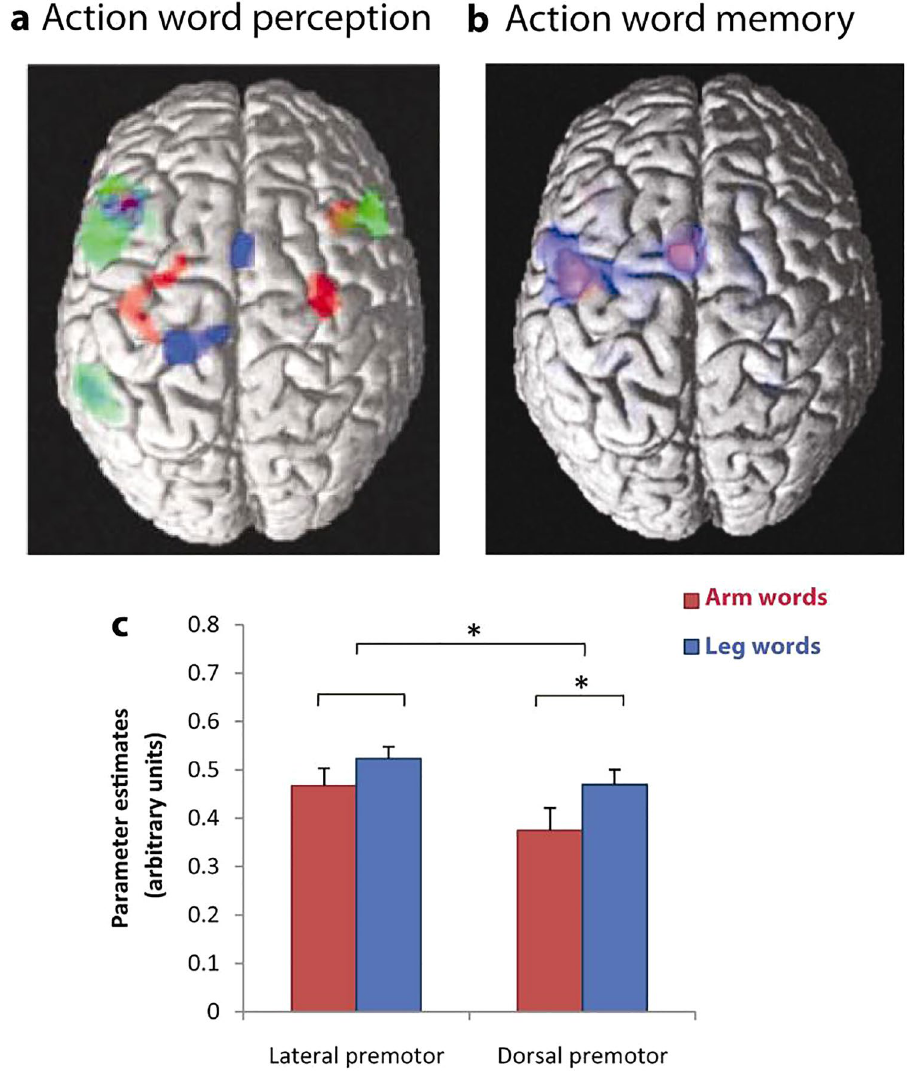
Figure 4. ( a , b ) Comparison between dorsal views of word category effects seen in the present working memory study and in an earlier study of word reading using a similar set of arm- and leg-related words 70 . The previous study’s results are displayed on the left, with activity to face-related words in green, that to arm-related words in red, and that to leg words in blue. The brain diagram on the right presents results on memory load effects from the present investigation ( p < 0.001 uncorrected) with arm word-memory load highlighted in red and memory load for leg words in blue. Note the anterior shift of category-specific activation in verbal working memory relative to reading. ( c ) Significant interaction of ROI and Word Category in the present study showing stronger activation for leg-word than arm-word memory in dorsal premotor